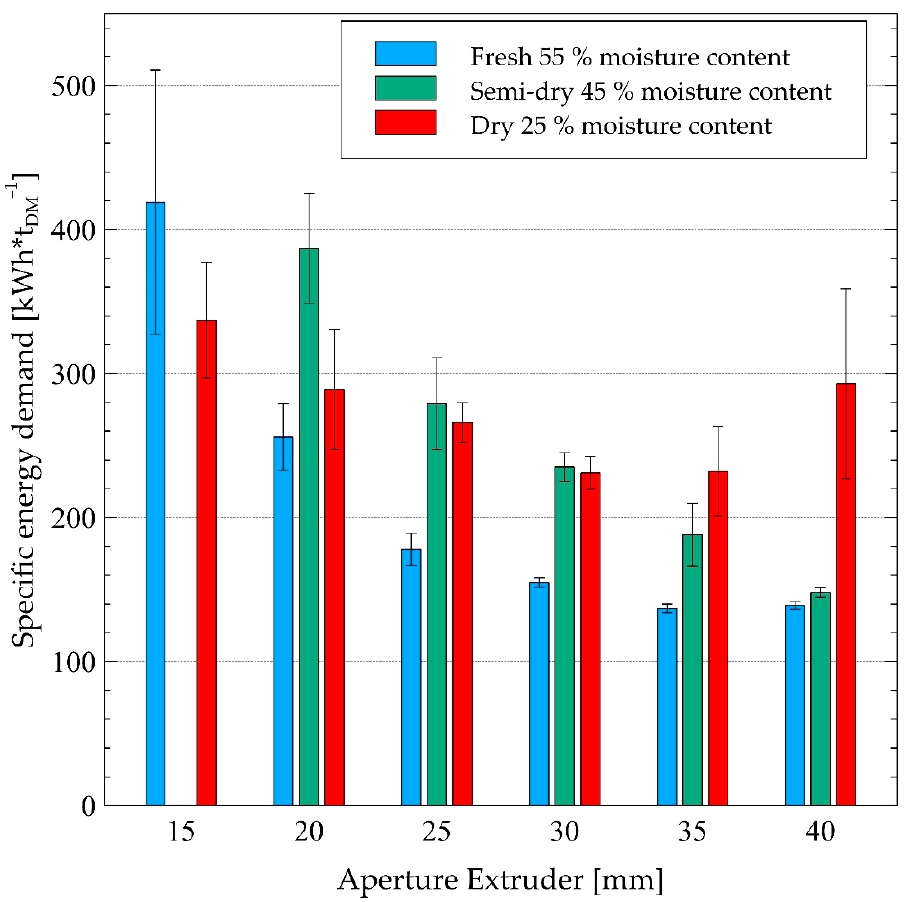
Figure 4. Specific energy demand for all apertures and moisture contents.